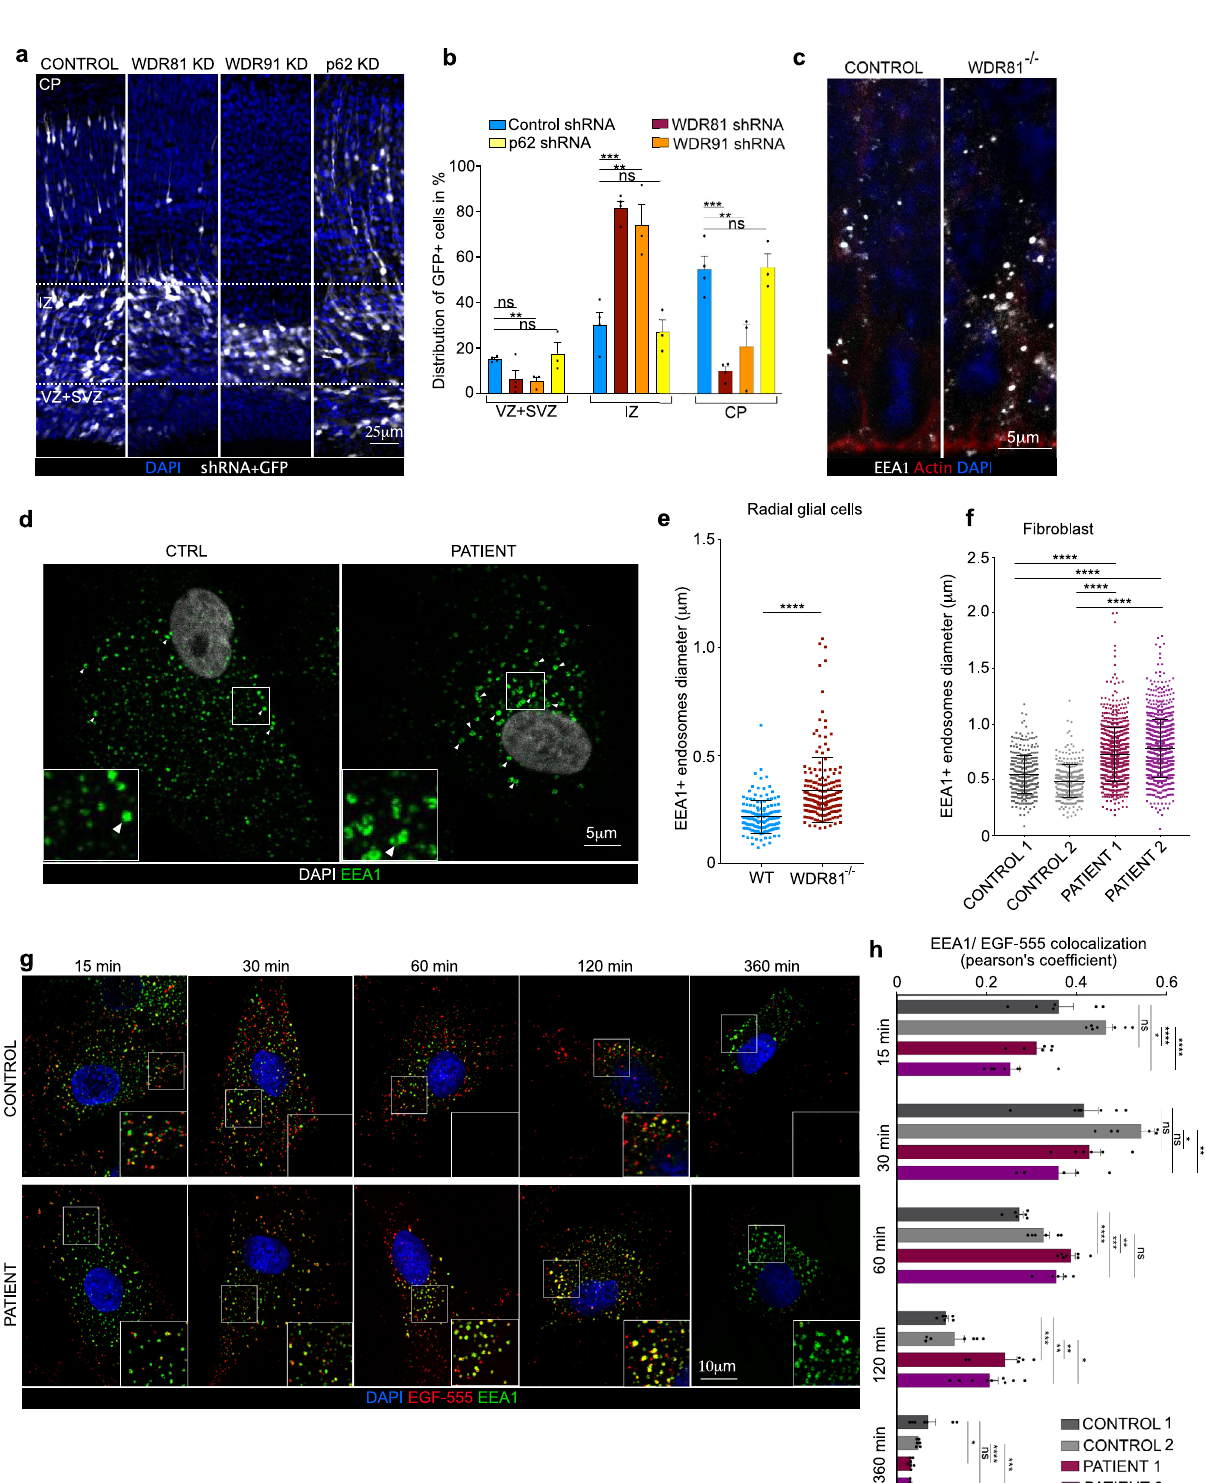
expressed using in utero electroporation in WT and WDR81- mutant mice brains at E14.5, and the mitotic index of PAX6 cells was measured at E16.5. Following expression of the control